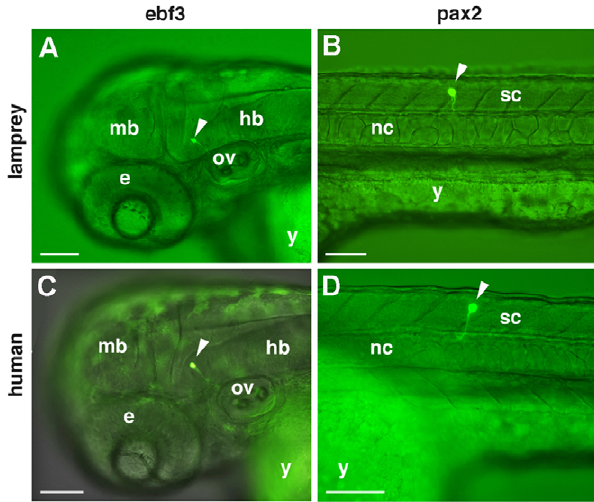
Figure 3. Up-regulation of GFP by lamprey and human derived CNEs. Images of live zebrafish embryos 48–54 hpf (A–C) and 24–30 hpf (D), lateral views, anterior to left. Images are shown as GFP fluorescent (A,B,D) and (C) merged fluorescent and bright field views. (A,C) GFP expression in the hindbrain, driven by an EBF3 CNE derived from lamprey and human respectively. (B,D) GFP expression in the spinal cord driven by a PAX2 CNE derived from lamprey and human respectively. e, eye; hb, hindbrain; mb, midbrain; nc, notochord; ov, otic vesicle; sc, spinal cord; y, yolk. Scale bars represent 100 m m.